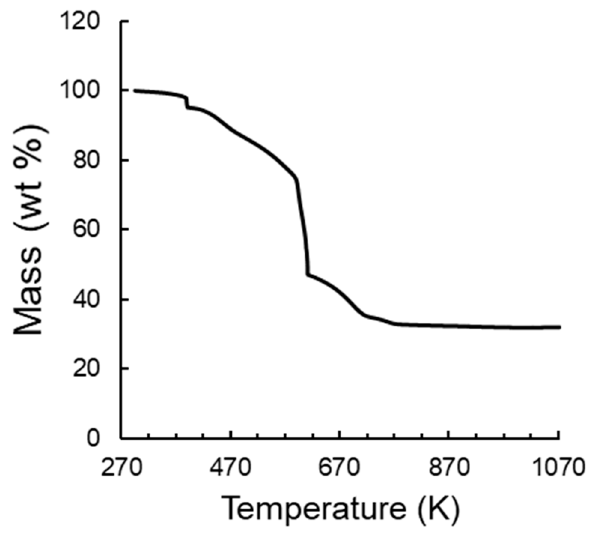
Figure 6 . The TGA of compound 2 from room temperature to 1073 K under air. Figure 6. The TGA of compound 2 from room temperature to 1073 K under